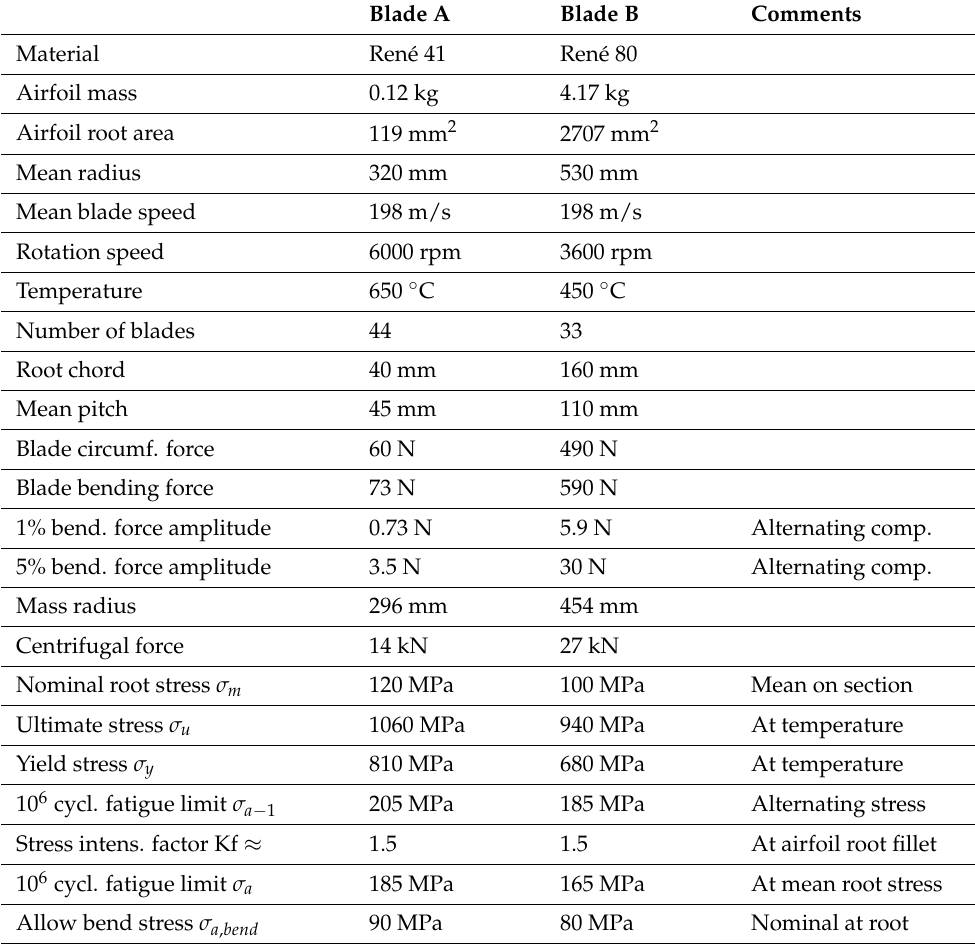
Table 3. Data relevant to the estimate of fatigue limits of blades A and